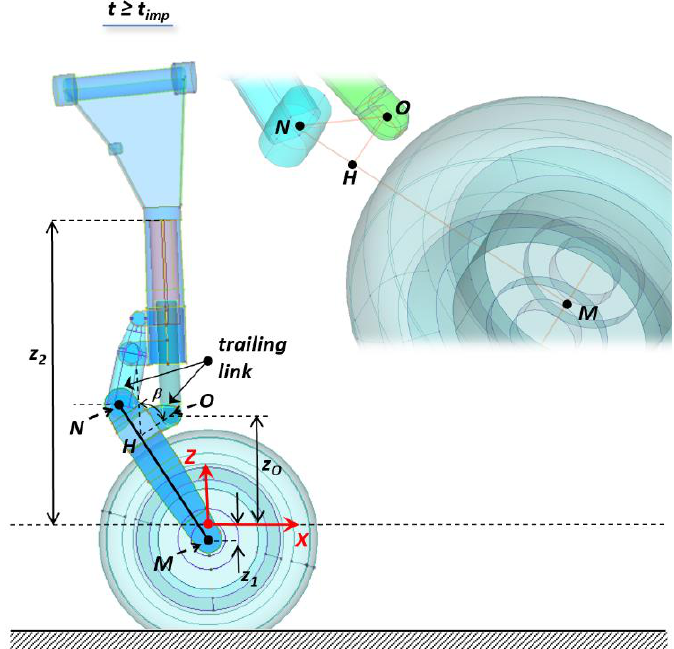
Figure A1. Landing gear with trailing link after the impact. The vertical coordinate, z , of the generic point on segment 𝑀𝑁̅̅̅̅̅ located at a distance ε from M can be expressed as: